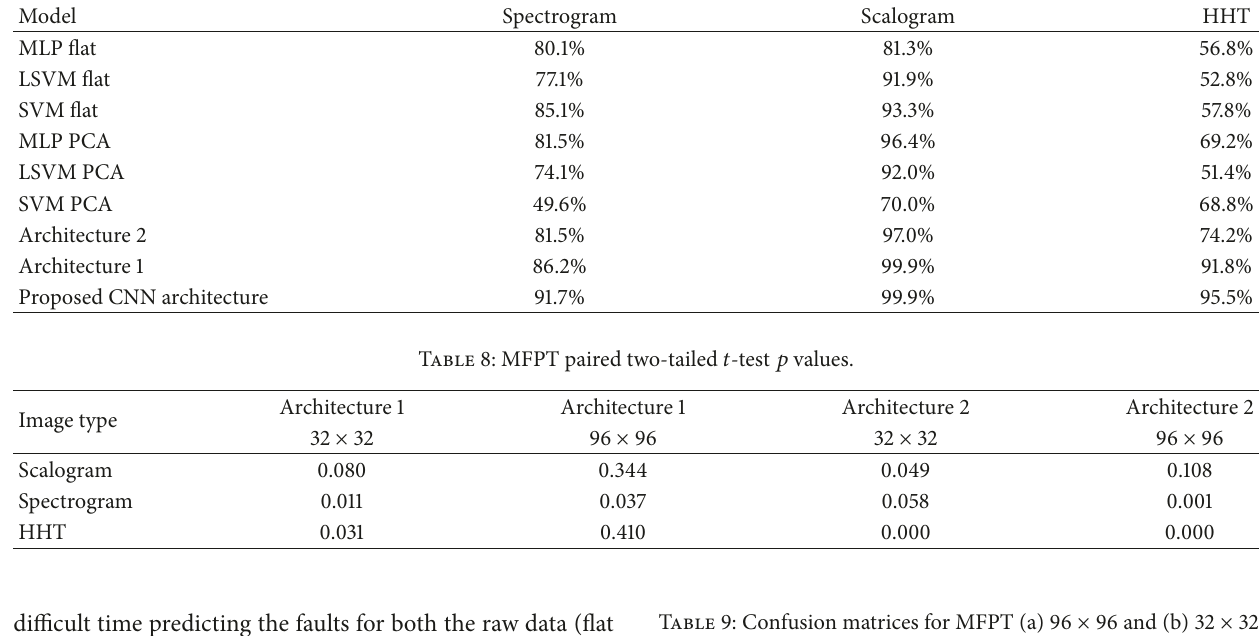
Table 9: Confusion matrices for MFPT (a) 96 × 96 and (b) 32 × 32 scalograms for the proposed